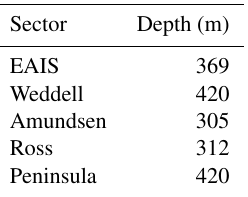
Table 2. Mean ice shelf depth (in m) for the five sectors in Fig.